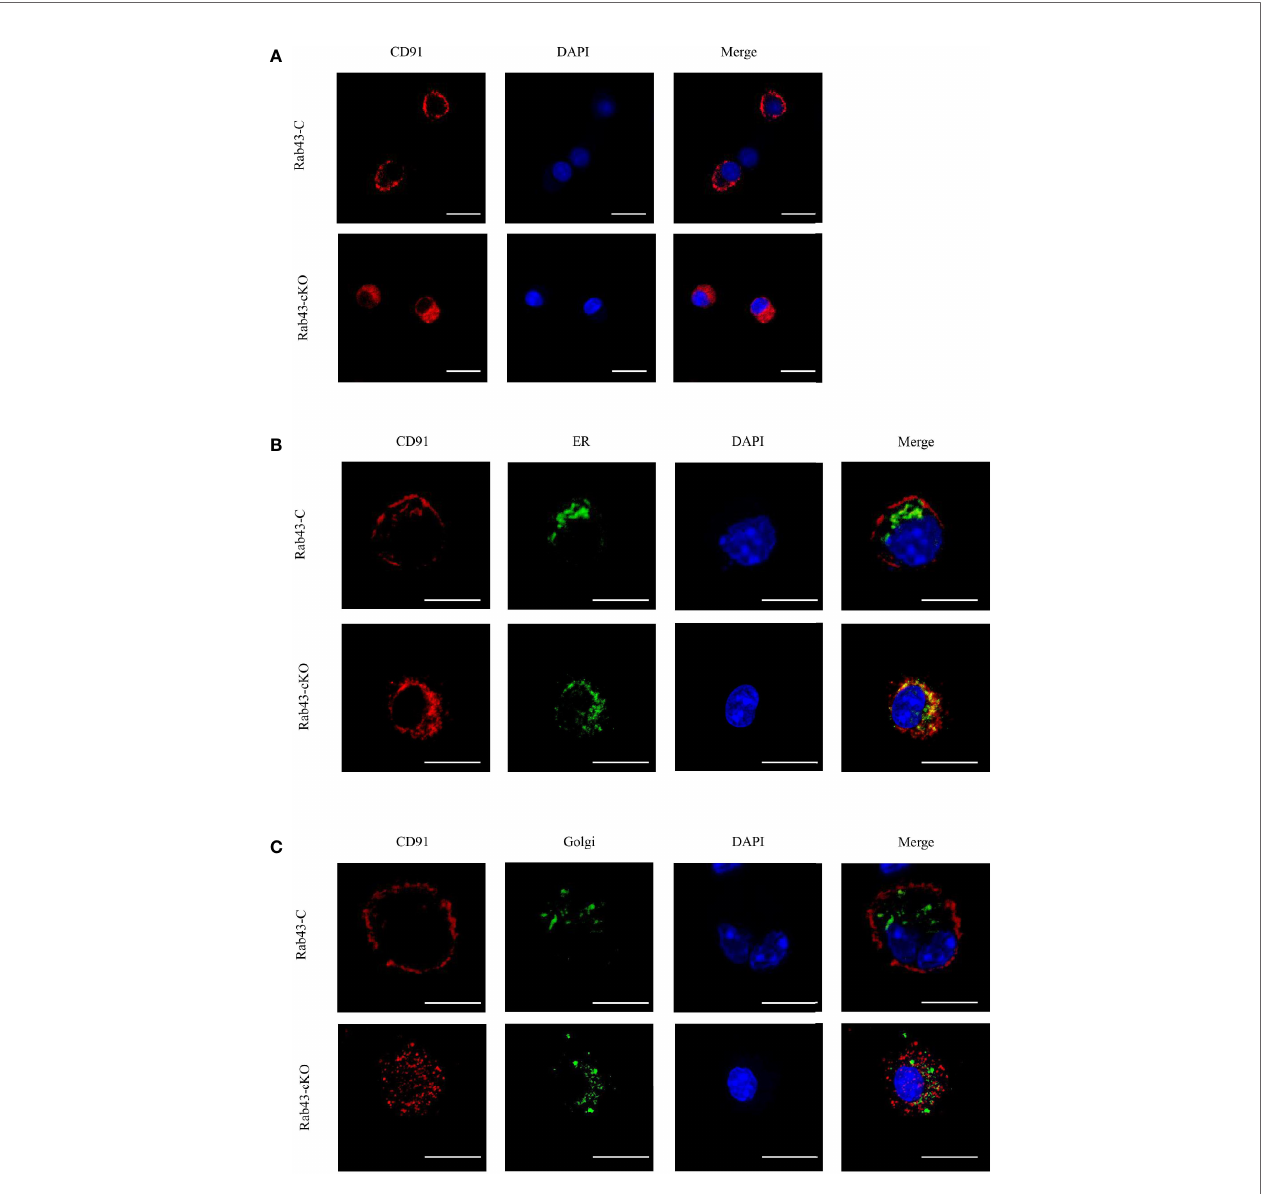
FIGURE 6 | Rab43 regulates the transport of CD91 to the cell surface. (A) Localization of endogenous CD91 in Rab43-C and Rab43-cKO bone marrow-derived macrophages (BMDMs). The Rab43-C and Rab43-cKO BMDMs were stained with anti-CD91 antibody. Red, CD91; blue, DAPI. Scale bars = 10.0 m m. (B) Co- localization of endogenous CD91 with the ER marker Calnexin. The Rab43-C and Rab43-cKO BMDMs cultured in glass-bottom dishes were stained with anti-CD91 antibody and anti-Calnexin antibodies. Red, CD91; green, Calnexin; blue, DAPI. Scale bars = 10.0 m m. (C) Co-localization of endogenous CD91 with the Golgi body. The Rab43-C and Rab43-cKO BMDMs cultured in glass-bottom dishes were fi xed with 4% formaldehyde solution for 10 min. Dual Detection Reagent was used to stain the Golgi body for 1 h. The cultured cells were then incubated with anti-CD91 antibody. Red, CD91; green, Golgi body; blue, DAPI. Scale bars = 10.0 m